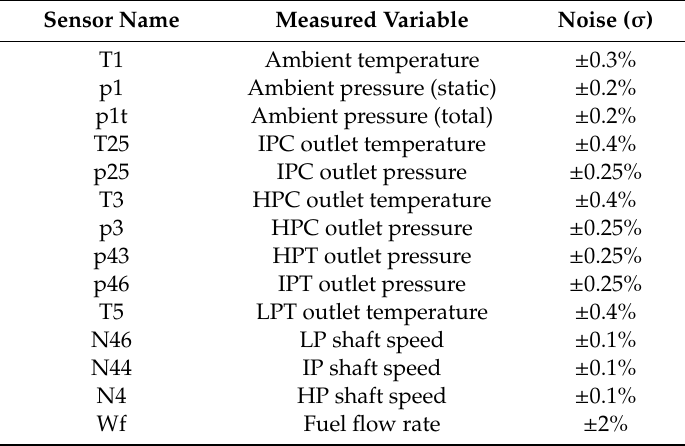
Table 5. Sensors list with considered noise level.